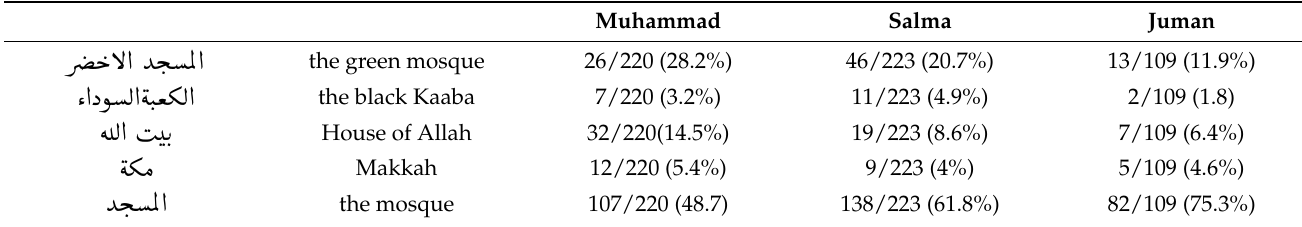
Table 1. The percentage of referring expressions for religious